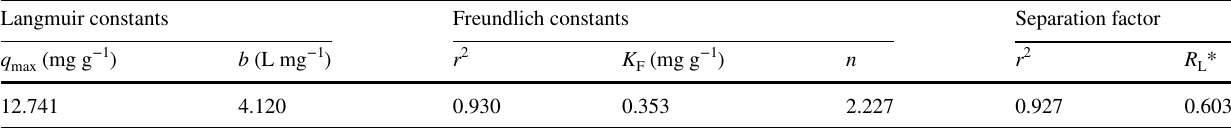
*Value is given for optimum dose (5.0 g l −1 ) and conc. of effluent (2.39 mg l −1